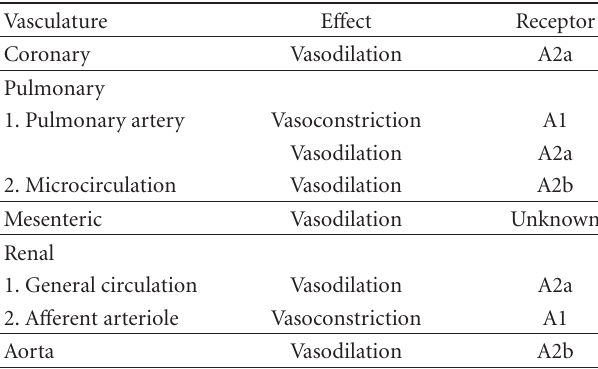
Table 2: Vascular e ff ects of